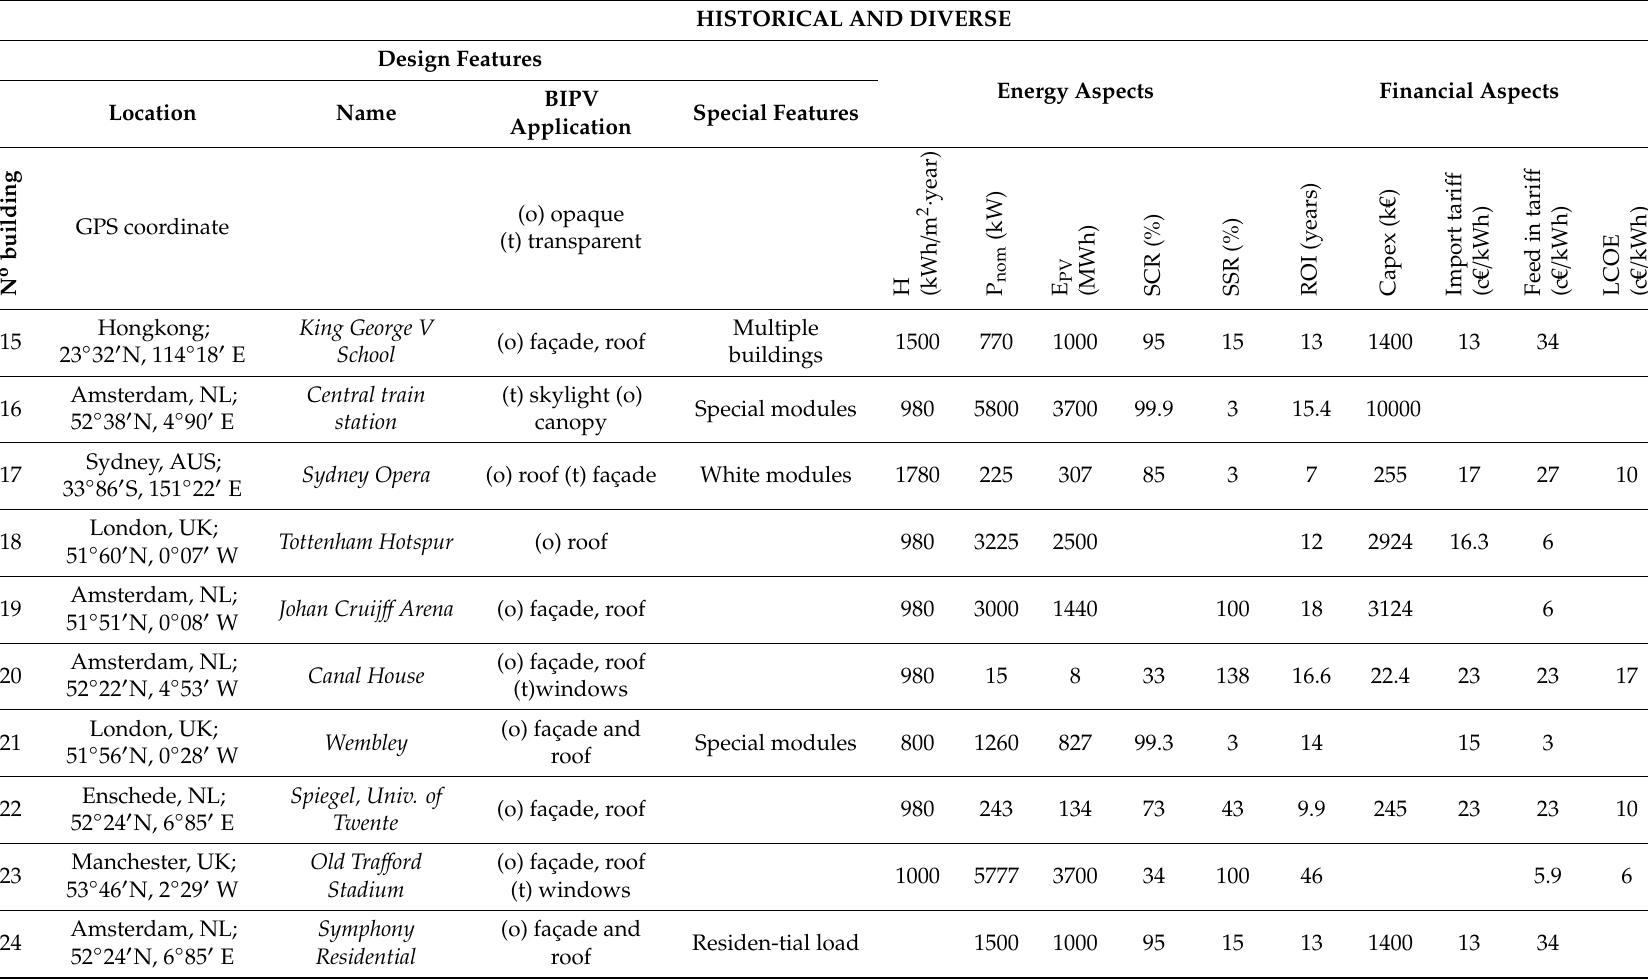
Table 4. Historical building and diverse projects—design specifications and numerical results in terms of energy and financial